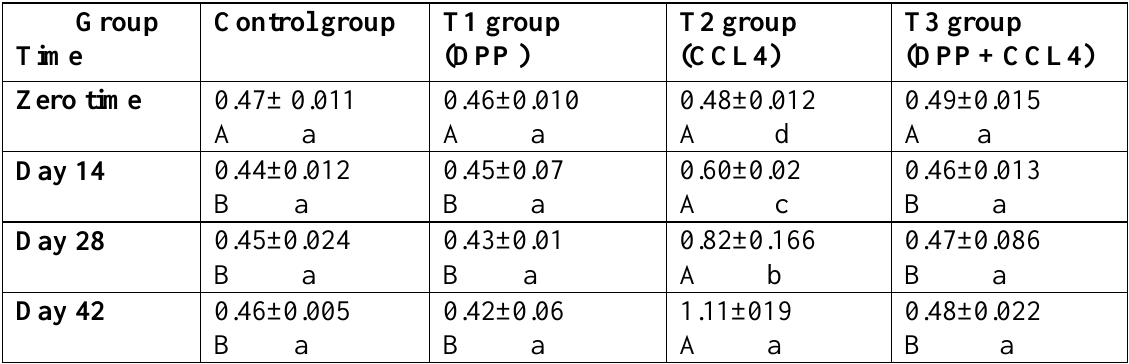
Table (4) Effect of DPP, CCL4 and DPP plus CCL4 on total serum Bilirubin (mg/dl) of adult male